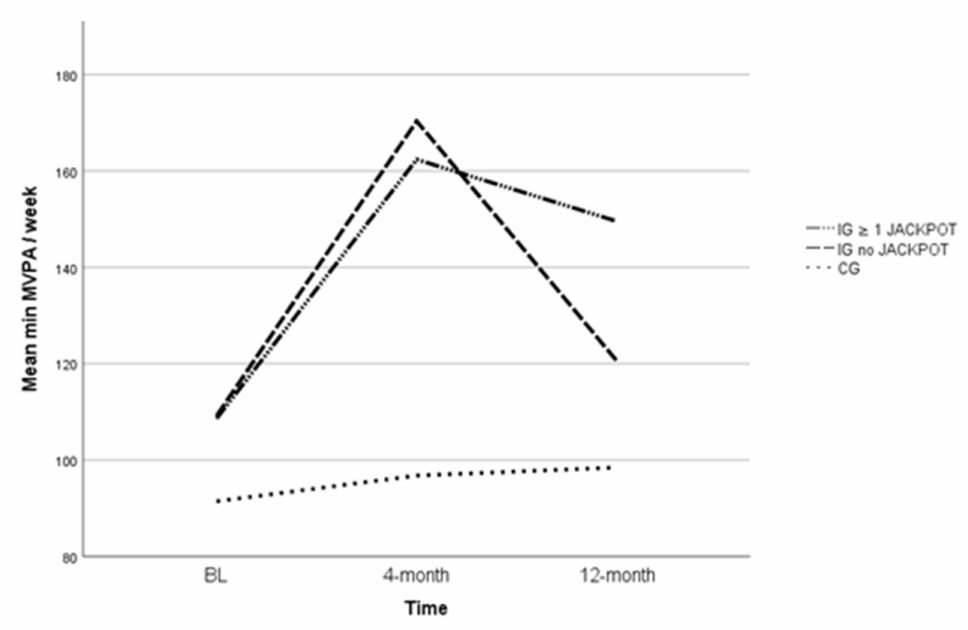
Figure 2. Accelerometer-assessed physical activity (PA) behaviour over